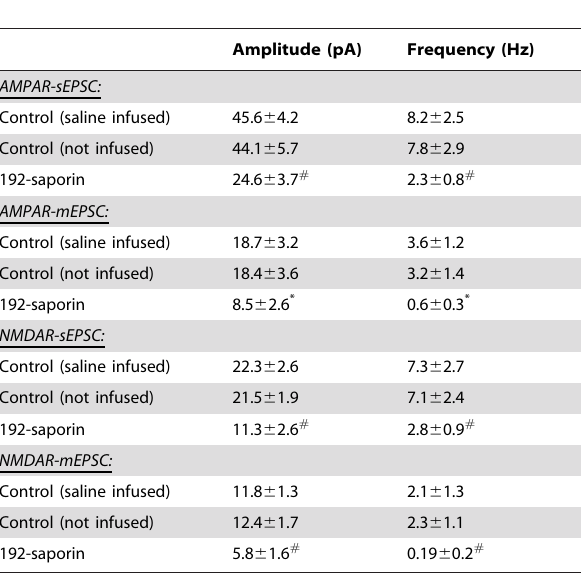
Table 1. Amplitude and frequency of whole cell currents mediated by AMPA and NMDA